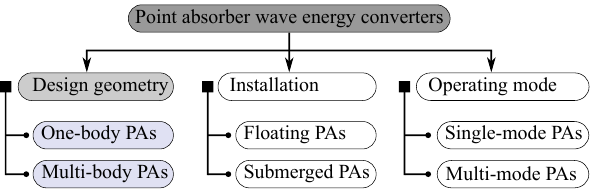
Figure 2. Point absorber wave energy converters can be further classified into subcategories according to the design geometry, manner of installation and operating mode.